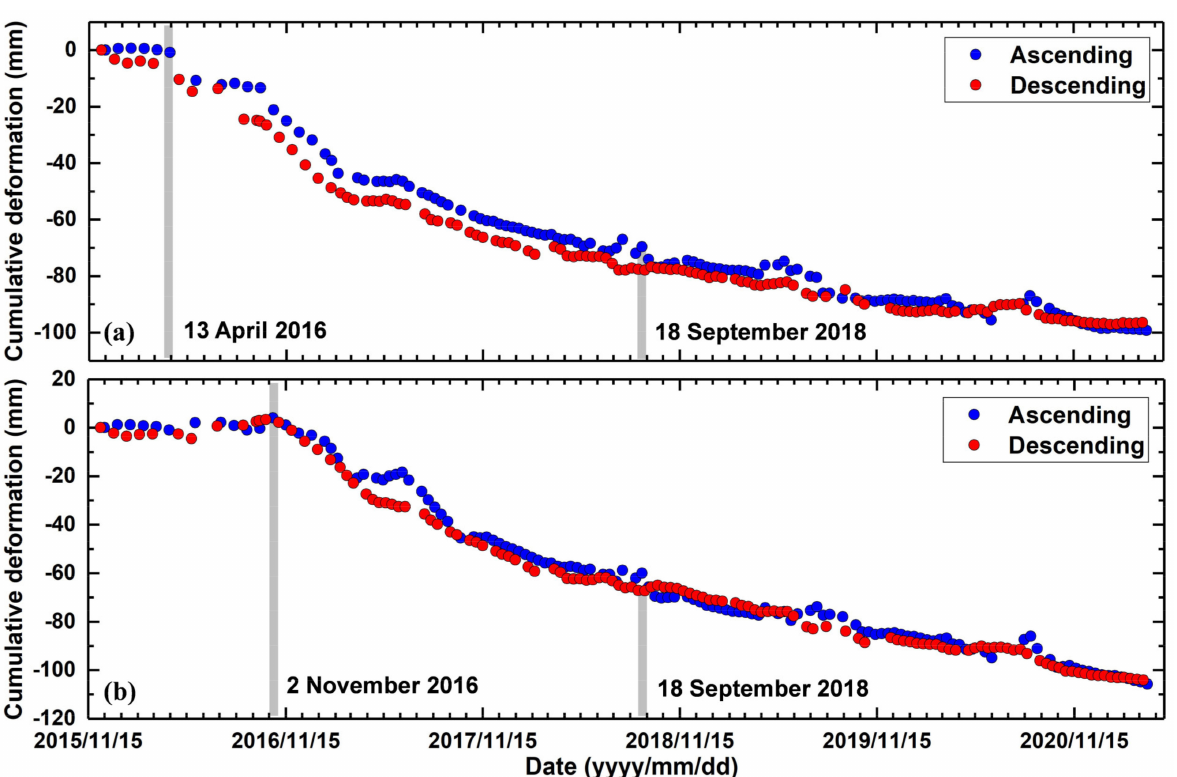
Figure 15. Time series of the displacement between December 2015 and March 2021 at Points P1 and P2 marked in Figure 13. The first grey bar indicates the time when the ground surface began to deform, and the second grey bar is the time when the tunnel excavation was completed. ( a ) P1; ( b ) P2. Back squares and red squares represent the ascending and descending displacements,